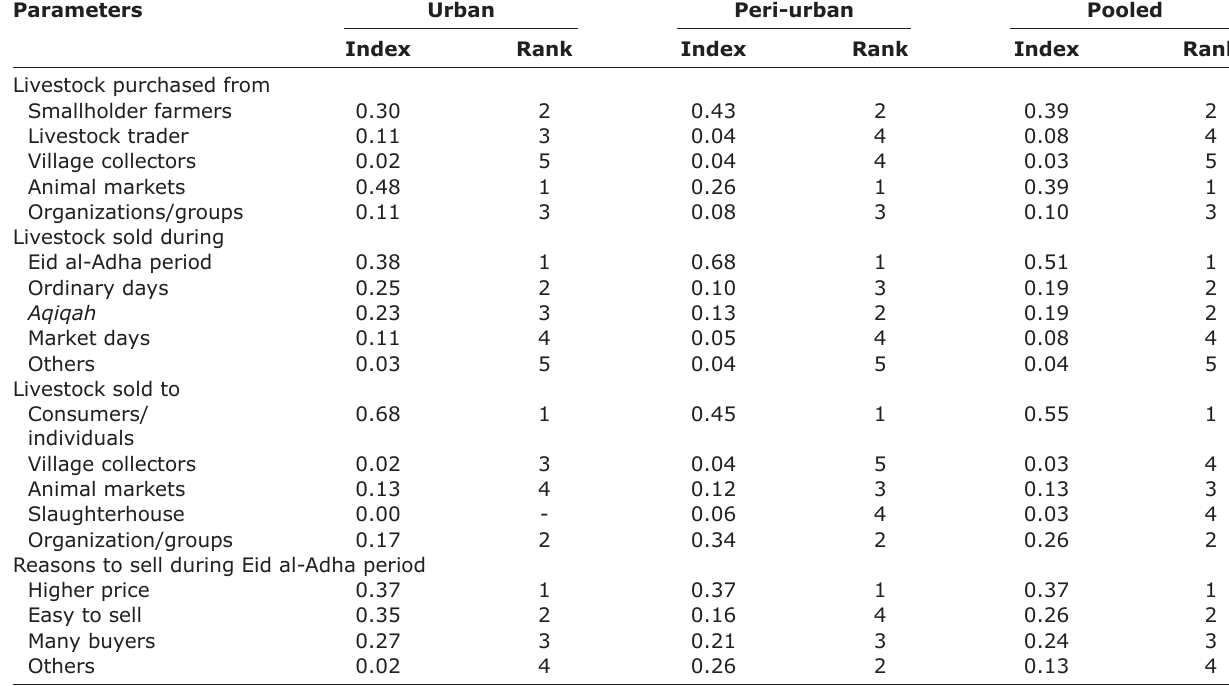
Table-3: Ranking analysis of preferences for livestock purchased and sold, sales moment, and reasons for sales during the Eid al-Adha period.